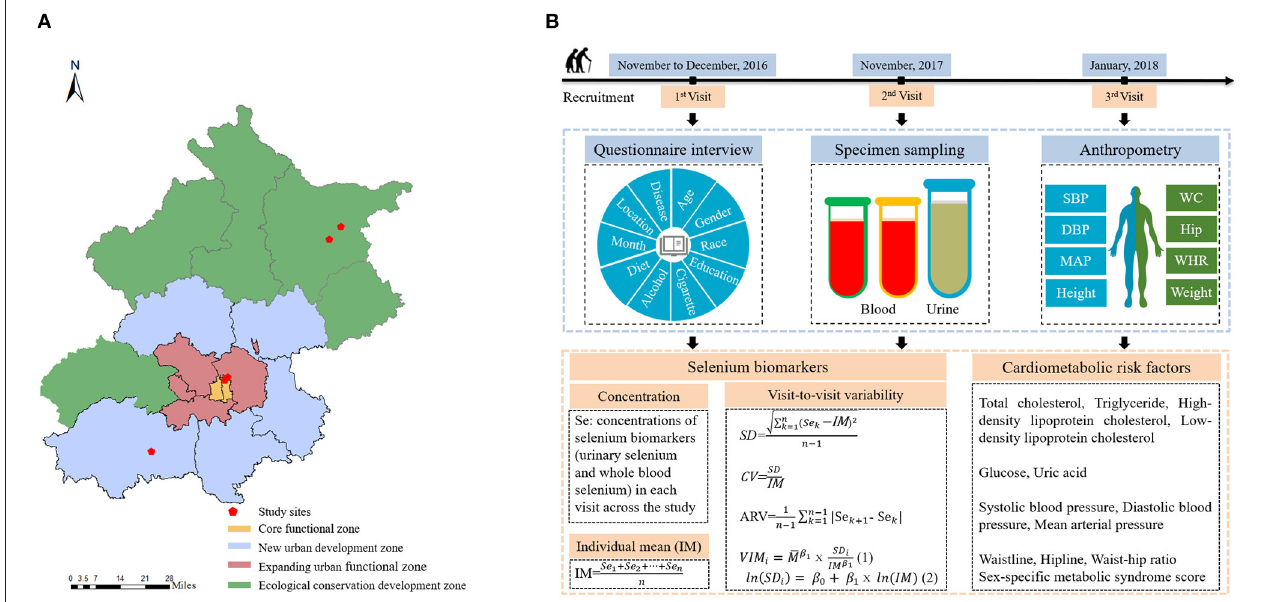
FIGURE 1 | (A) Five study locations within Beijing. (B) Overview of study design and data